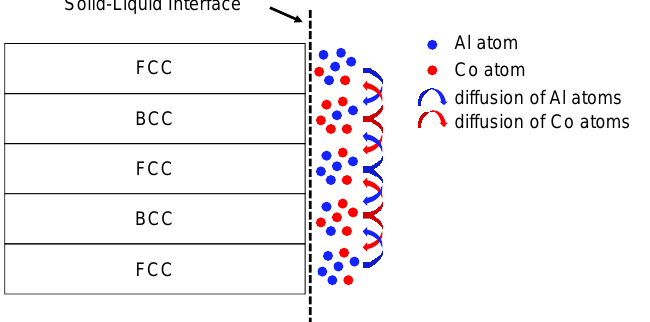
Figure 13. Schematic diagram of atomic diffusion in front of the solid–liquid interface during eutectic growth.